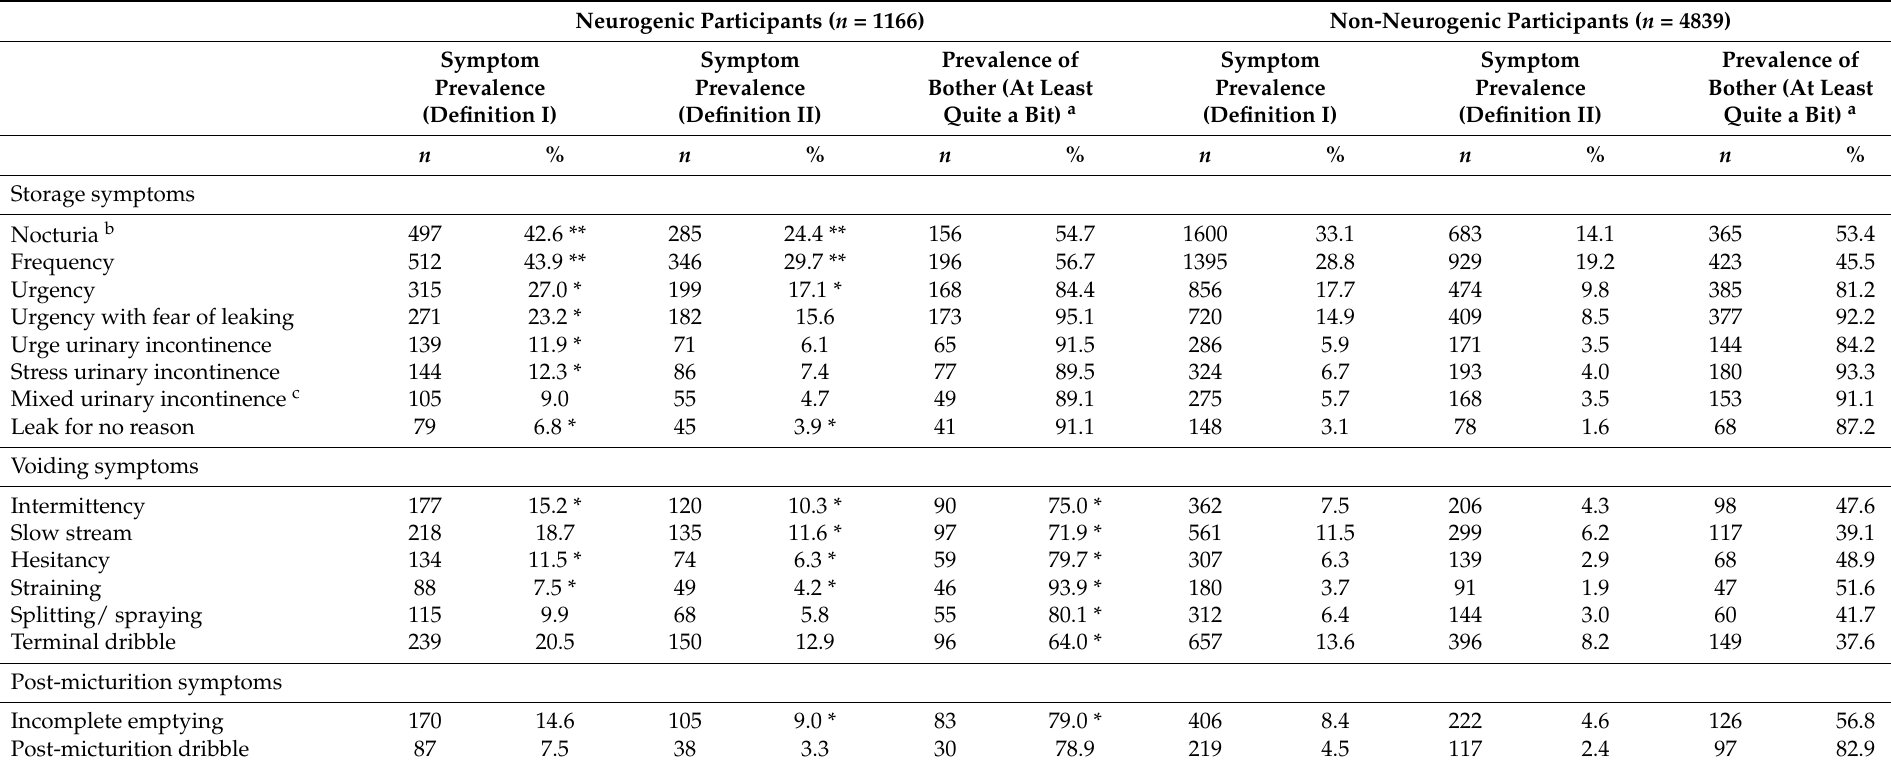
Table 1. Prevalence of specific symptoms according to definition I (symptoms occurring less than half the time or more) and definition II (symptoms occurring about half the time or more) and associated bother in neurogenic and non-neurogenic